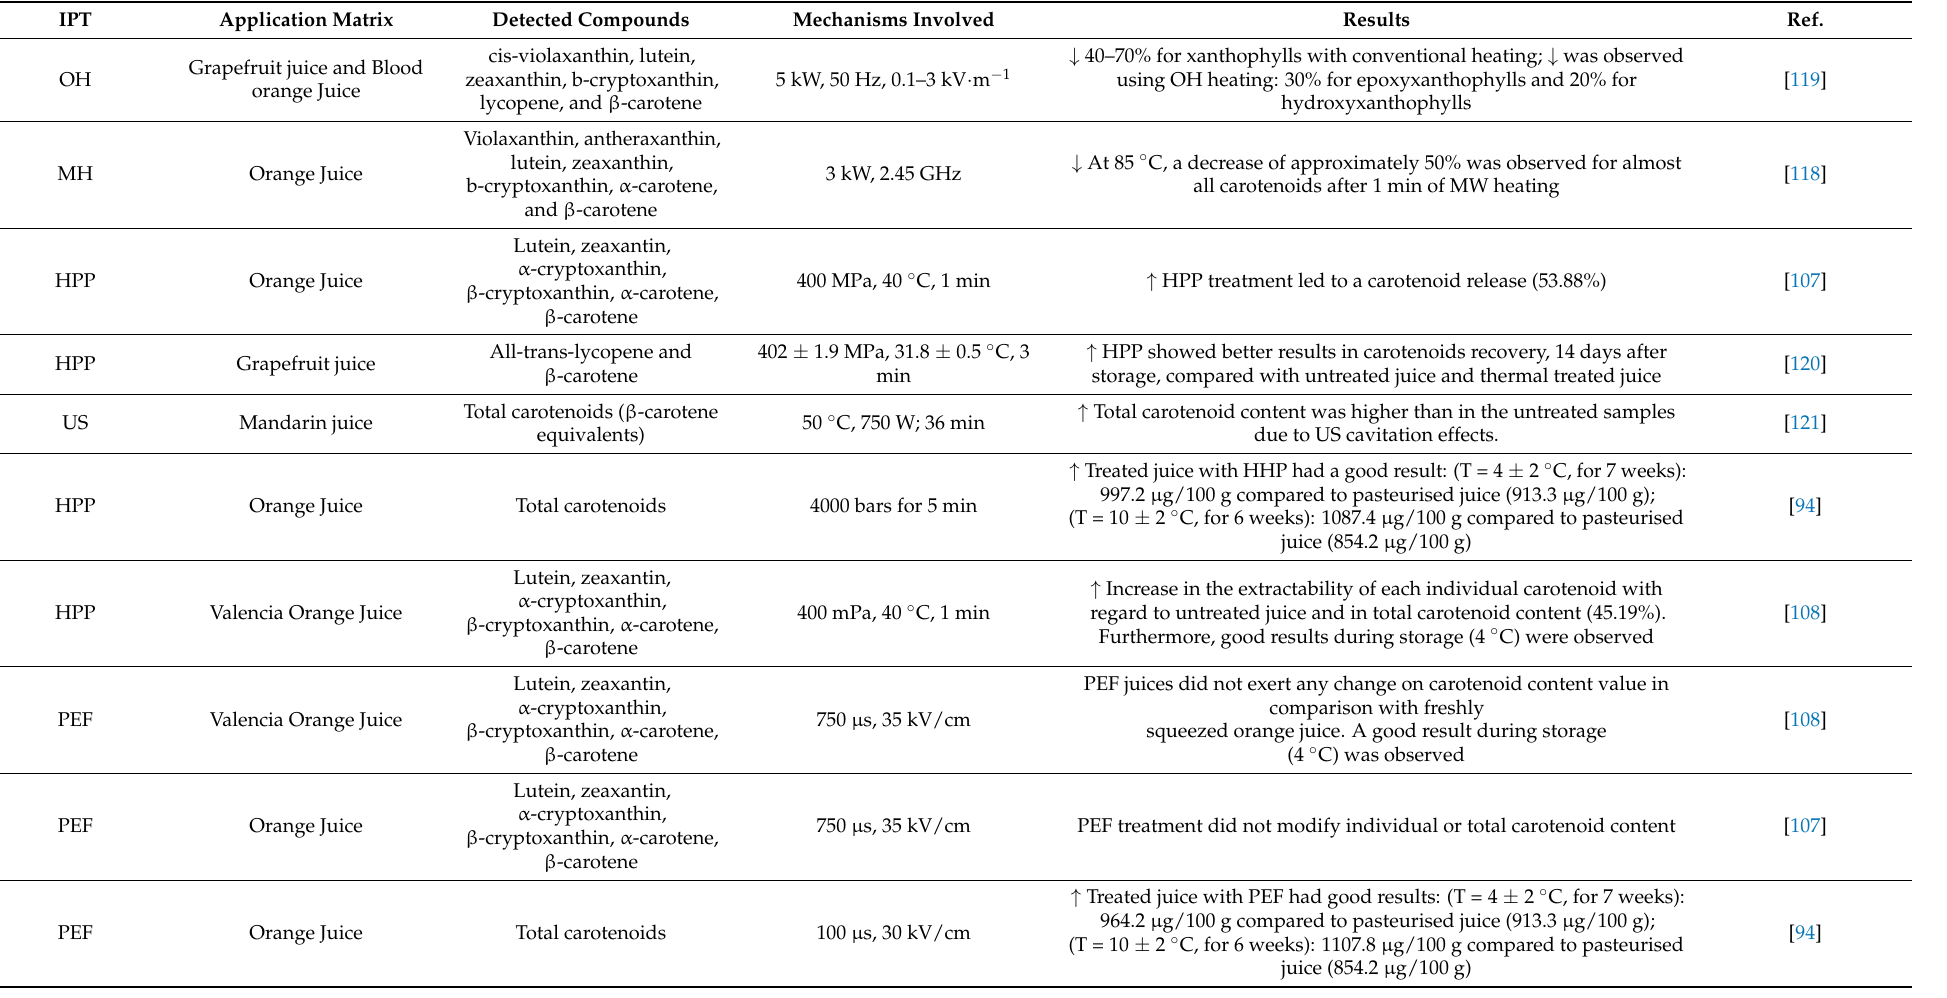
Table 5. Effects of innovative processing technologies on carotenoids content present in citrus